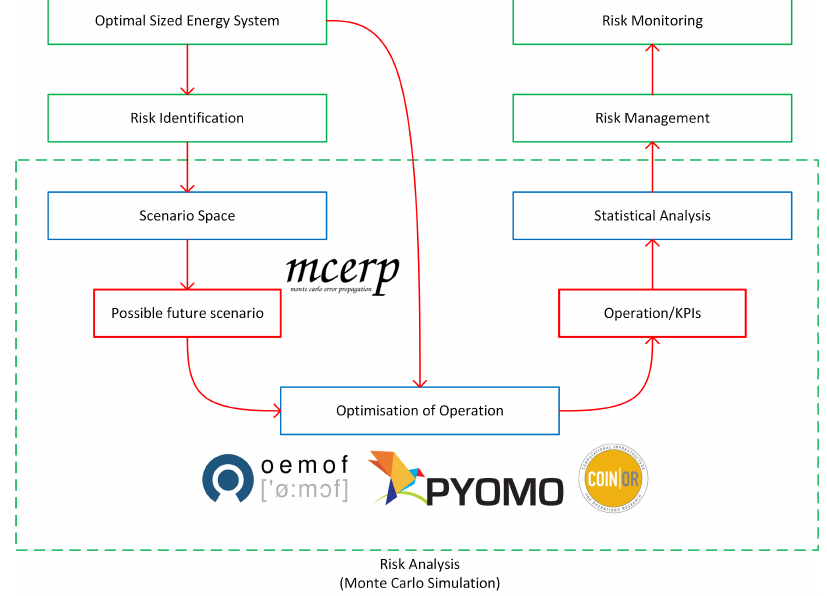
Figure 5. Flow chart of Monte Carlo based risk analysis of the optimized energy supply scheme. Here, too, the interaction of the selected software solutions is shown in particular, which is also realized in